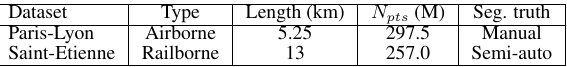
Table 1. Railway LIDAR datasets characteristics